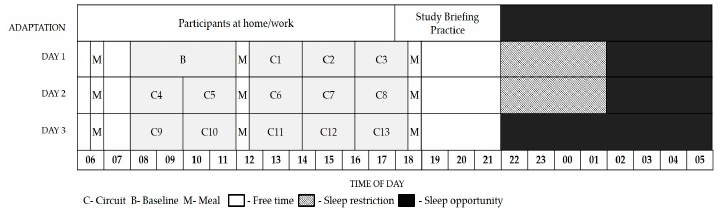
Figure 1. Schematic of study protocol.